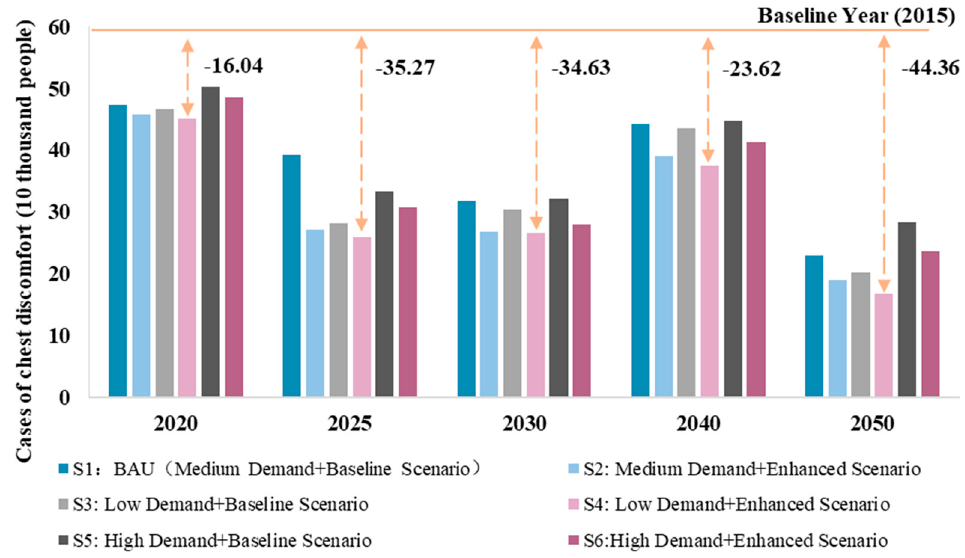
Figure 4. Health effects of SO 2 emissions under different scenarios in the steel sector.